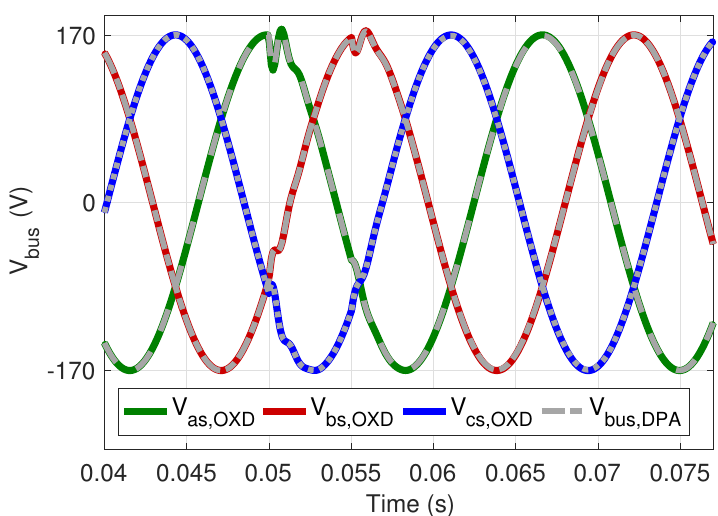
Figure 7. Scenario 2: OXD and DPA abc bus voltage response to the bus load step at t = 0.05 s followed by the largest inverter being eliminated from the microgrid at t = 0.055 s. OXD controlled bus voltage is shown in red, green, and blue, with the DPA controlled bus voltage overlayed in gray.